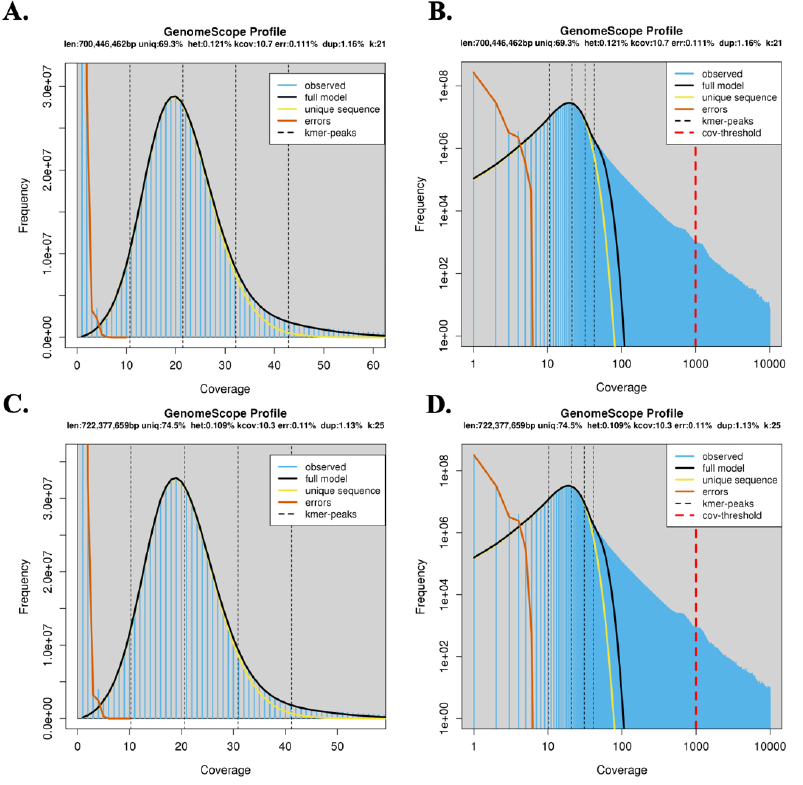
Figure 2. GenomeScope profile of the Pusa Ruby short reads using k-mer size 21 ( A , B ), and 25 ( C , D ). The larger peak is the homozygous region of the genome, accounting for unique 21-mers ( A , B ), and 25-mers ( C , D ) in both the strands of DNA. Low heterozygosity and repeat content were found using this analysis, with coverage being 10.3. Error in sequencing due to PCR is represented by the unique sequences on the left of the graph. The % PCR duplication was also found to be